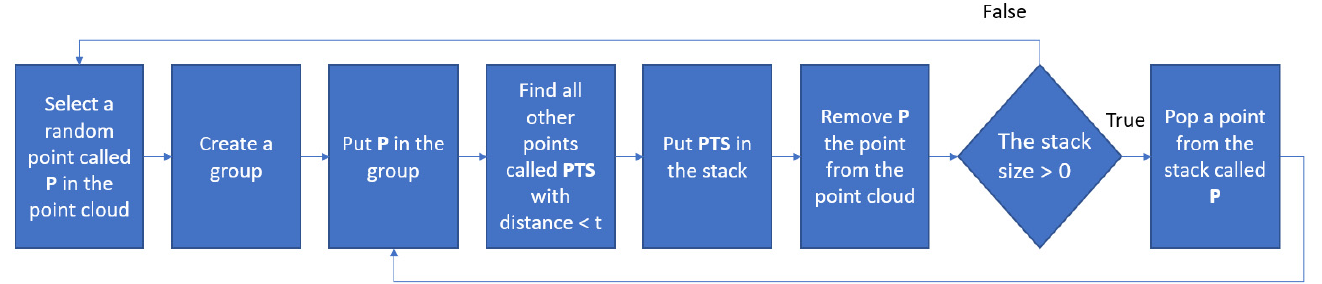
Figure 8. The diagram of extracting pruning group points.